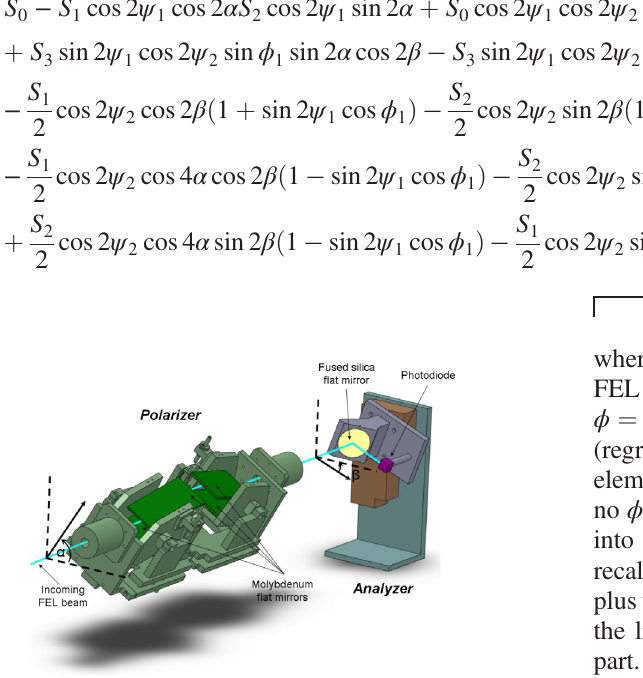
FIG. 5. VUV-optical polarimeter setup. The polarizer and the analyzer are placed into two successive vacuum chambers. The whole setup, approximately 1.5 m long, is positioned downstream of the DiProI end station. In front of and behind the polarizer, two irises of 5 mm diameter are used for aligning the polarimeter on the FEL axis. The α angle ranges from − 30 ° to þ 40 °, the β angle from − 170 ° to þ 170